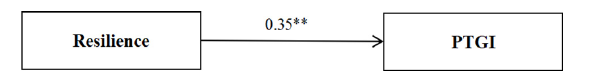
FIGURE 2 | Standardized solution for the structural equation model of resilience and posttraumatic growth. ∗∗ Significant at the 0.01 level (two-tailed).